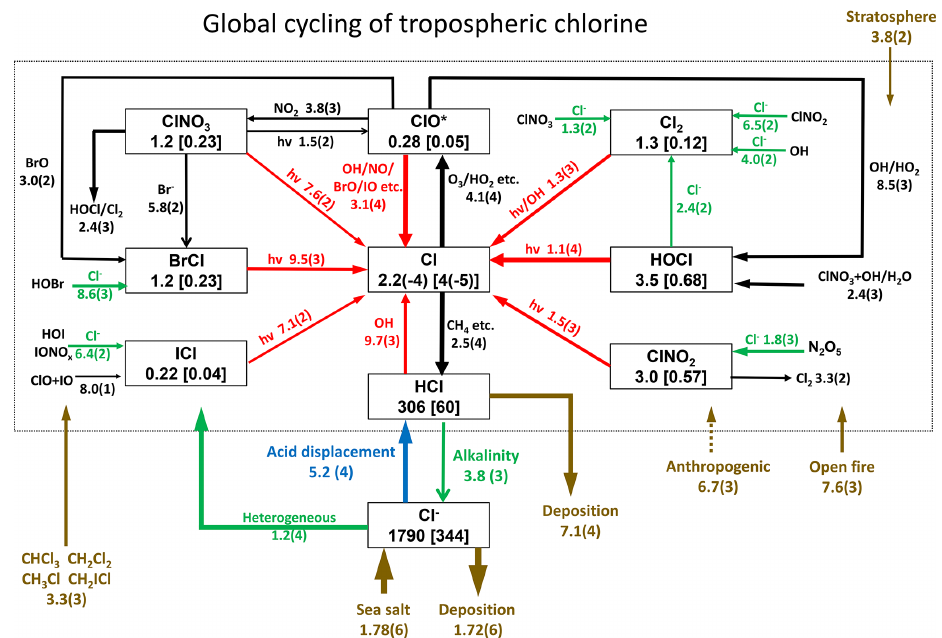
Figure 1. Global budget and cycling of tropospheric inorganic chlorine (Cl y ) in GEOS-Chem. The figure shows global annual mean rates (GgCla − 1 ), masses (Gg), and mixing ratios (ppt, in brackets) for simulation year 2016. Read 2.5(4) as 2 . 5 × 10 4 . ClO ∗ stands for ClO + OClO + ClO 2 + 2 × Cl 2 O 2 ; 84% is present as ClO. Reactions producing Cl atoms and related to Cl − heterogeneous chemistry are shown in red and green, respectively. The dotted box indicates the Cl y family, and arrows into and out of that box represent general sources and sinks of Cl y . Reactions with the rate < 100GgCla − 1 are not shown. Anthropogenic emissions of HCl as indicated by a dashed line are only included in a sensitivity simulation (see Sects. 2.2 and 4.2 for